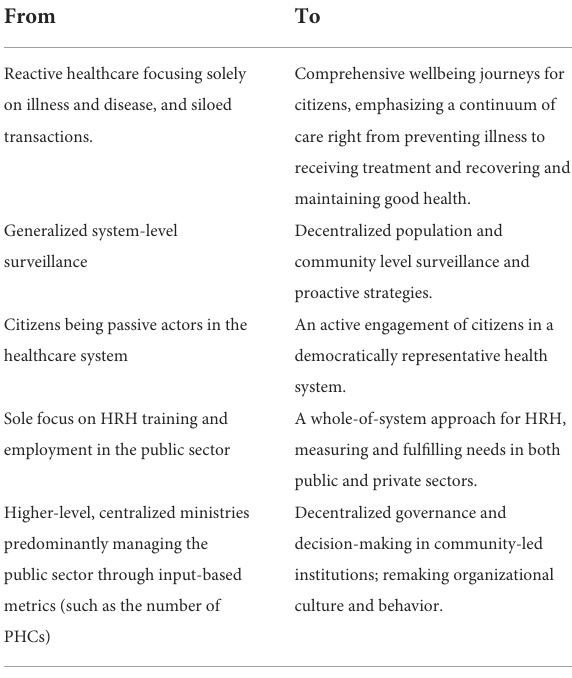
TABLE 1 Paradigm shifts required to achieve universal health care. From